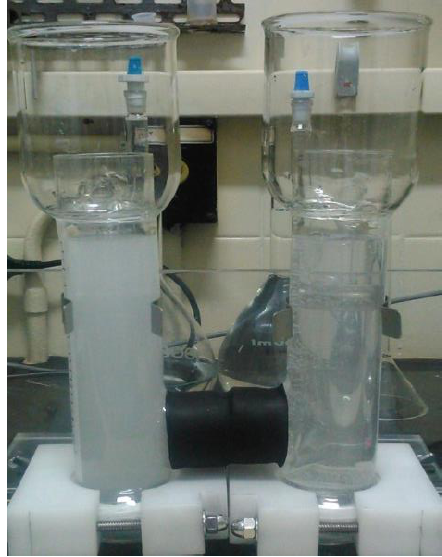
Figure 1. Modified Partridge-Smith binary cell.